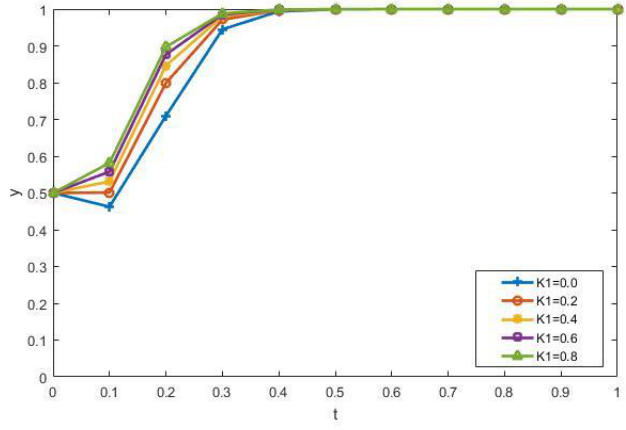
Figure 8. The impact of K 1 on the evolutionary results.